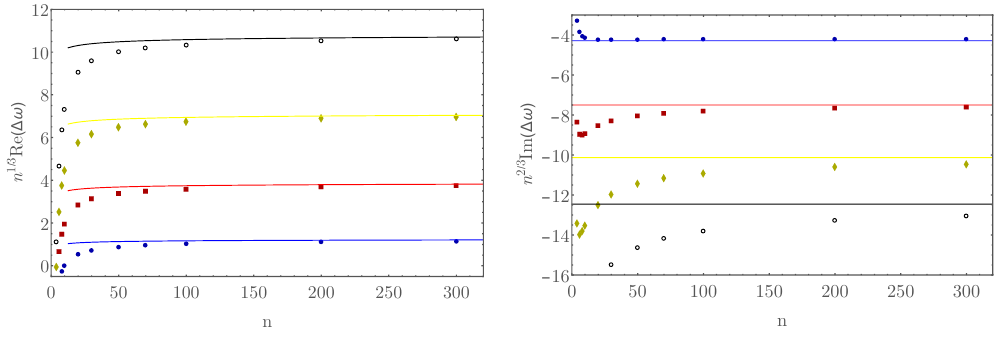
Figure 1 . Real (left) and imaginary (right) parts of the (cid:12)rst four quasi normal modes of black- branes in di(cid:11)erent numbers of dimension D = 1+ n in the spin-2 channel at zero spatial momentum. (cid:0) (cid:1) In both panels (cid:1) ! = ! QNM (cid:0) n 1 = 2 + (cid:14)! 1 n (cid:0) 2 = 3 + (cid:14)! 2 n (cid:0) 1 , with (cid:14)! 1 the corresponding zero of the Airy function and (cid:14)! 2 given in eq. (B.26). The lines correspond to the real and imaginary parts